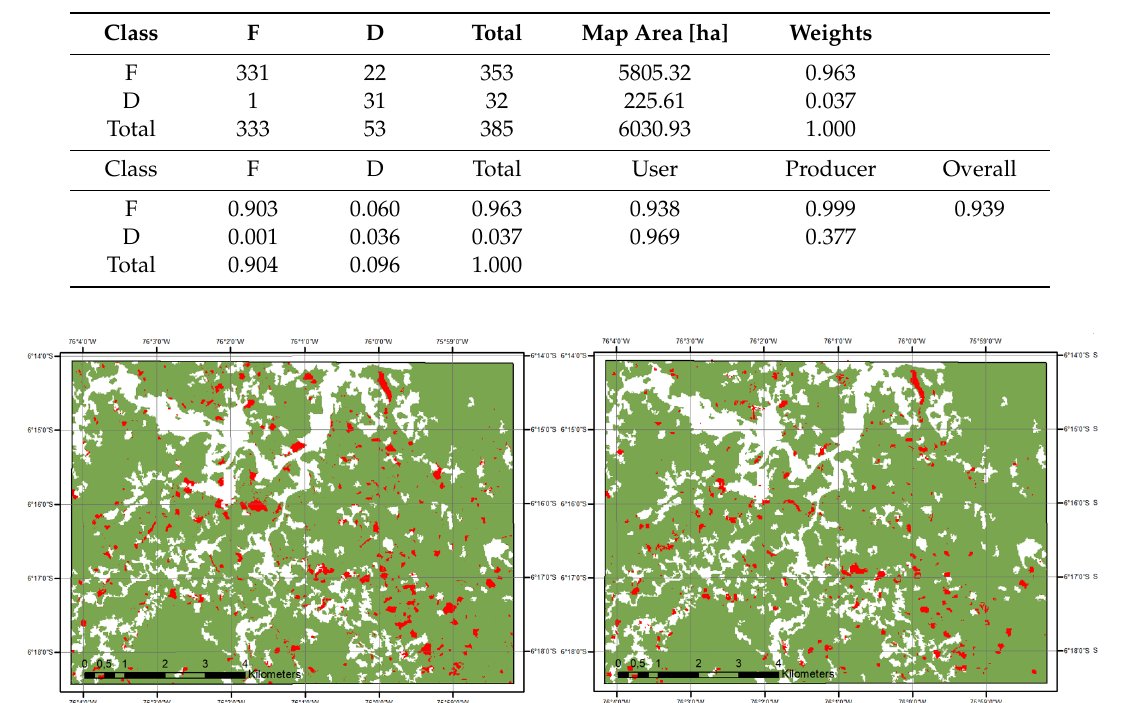
Table 7. Global Forest Watch changes of 2016 (version 1.6).